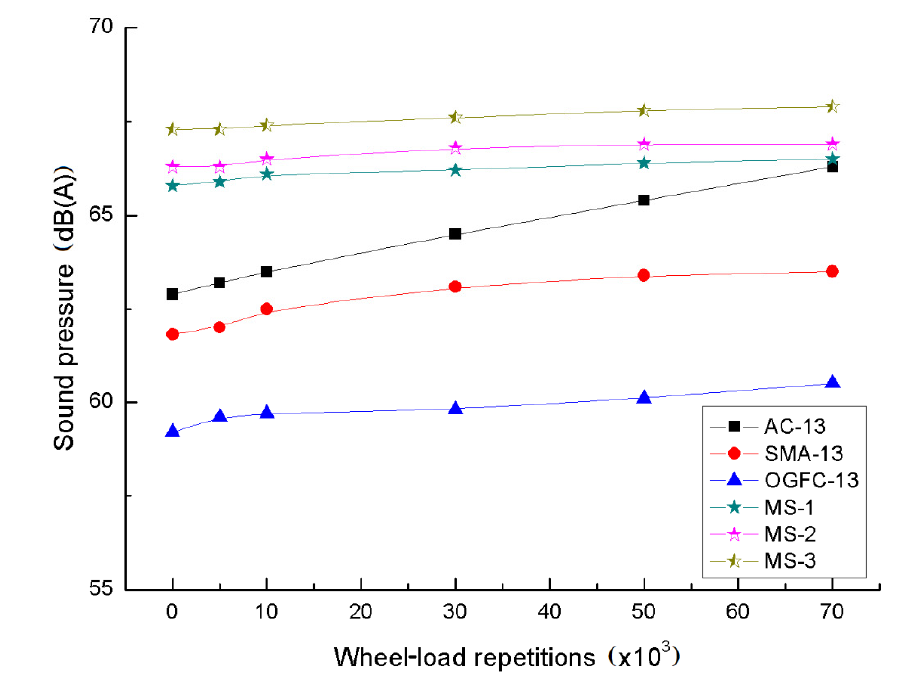
Figure 13. Tire–pavement noise of mixtures under different wheel-load repetitions.